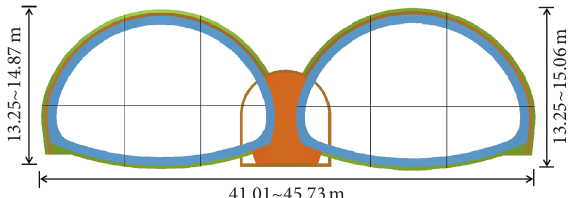
Figure 3: Cross section of the double-arch